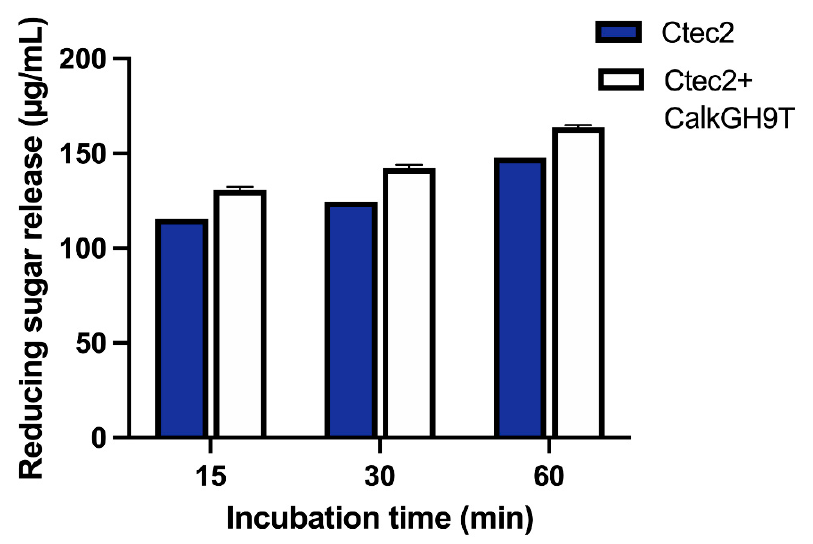
Figure 9. The effect of Calk GH9T addition to a commercial cellulase preparation Ctec2 on RAC hydrolysis. The enzymatic reaction was performed at pH 7.4 and 55 °C with a substrate loading of 1% ( w / v ) RAC and a total protein load of 100 µg. The reaction with Ctec2 alone (100 µg protein load) was used as a control. For supplementation of Ctec2 with Calk GH9T, Ctec2 was replaced with Calk GH9T by 10%, corresponding to a load of 90 µg Ctec2 and 10 µg Calk GH9T, respectively. Values are means and bars represent the standard deviations for three independent experiments.